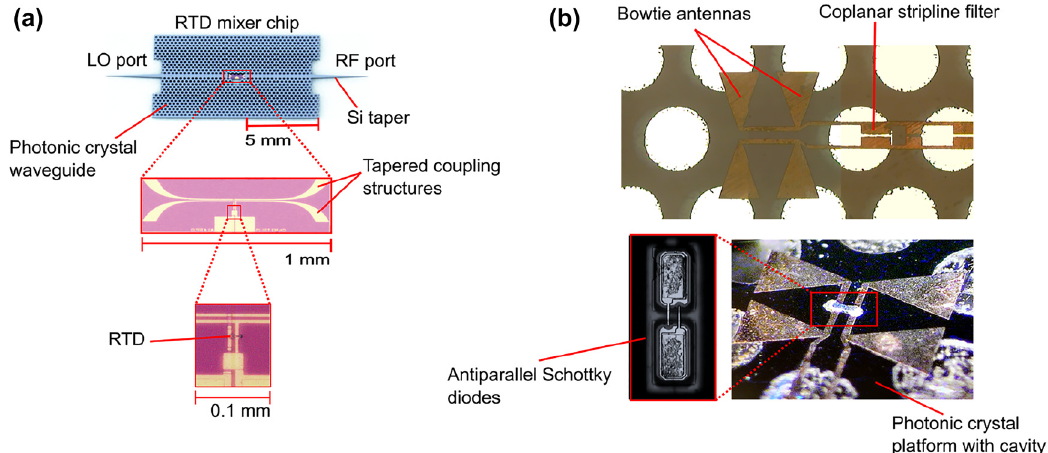
Figure 7: THz mixers integrated into Si photonic crystal platform. (a) RTD [106], (b) Schottky diode